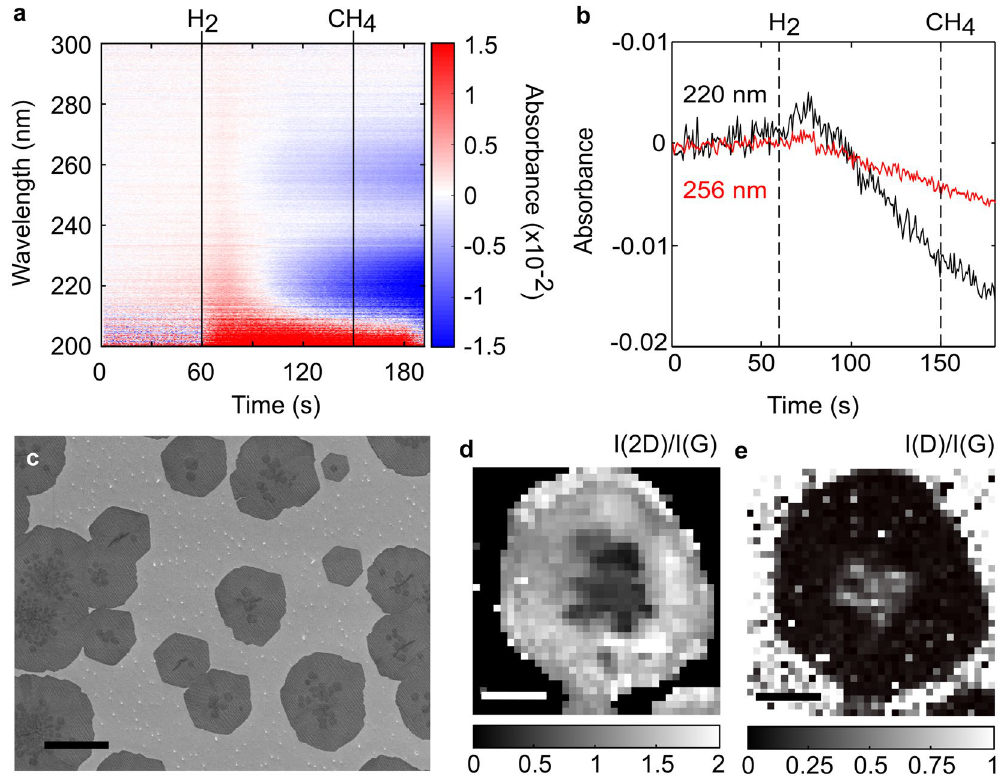
Figure 2. In-situ UV absorption spectroscopy and characterization of a standard CVD growth. (a) Time evolution of the absorbance spectra and (b) line profiles of the 220 nm (black) and 256 nm absorption peaks (red), with the dotted lines at 60 s and 150 s denoting when H 2 and CH 4 are introduced, respectively. ( c ) SEM image of the corresponding growth (scale bar 10 µ m). ( d,e ) Raman maps of a single graphene grain on